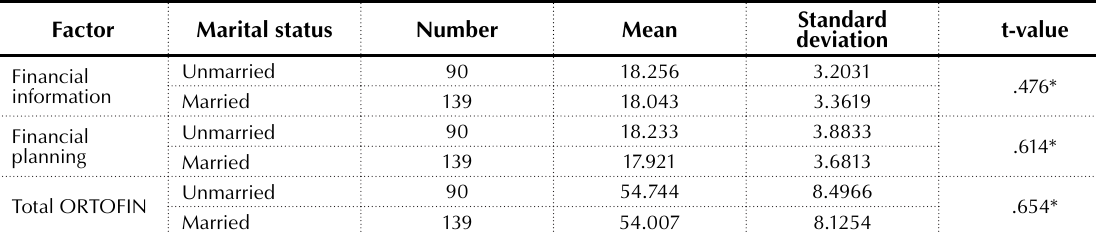
Table 4. Data and t-value based on marital status